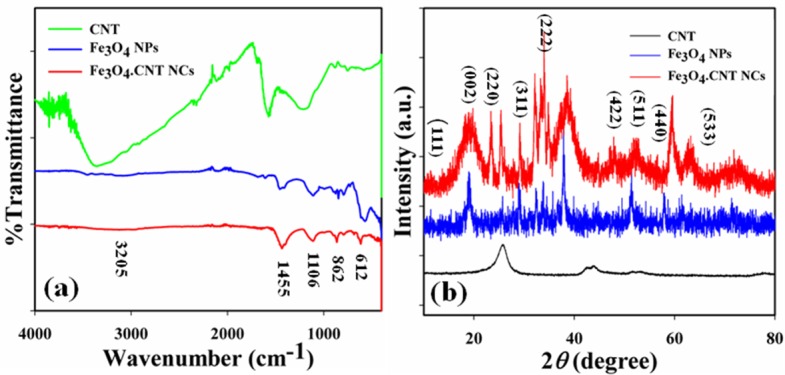
(a) FT-IR spectra, and (b) XRD patterns of CNT, Fe3O4 NPs and Fe3O4.CNT NCs.